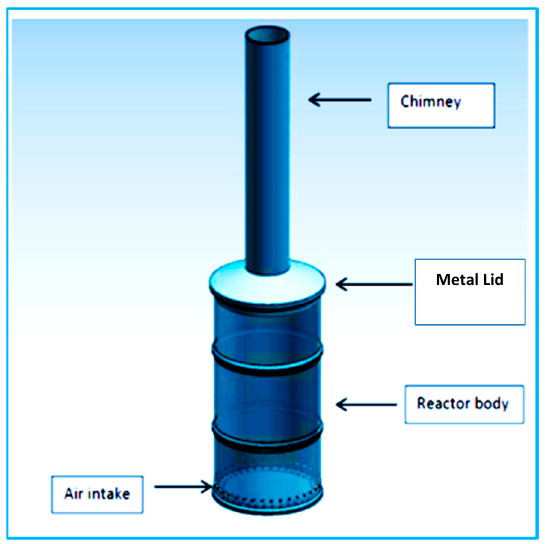
Figure 4. Schematic of top-lit updraft (TLUD) biochar unit.